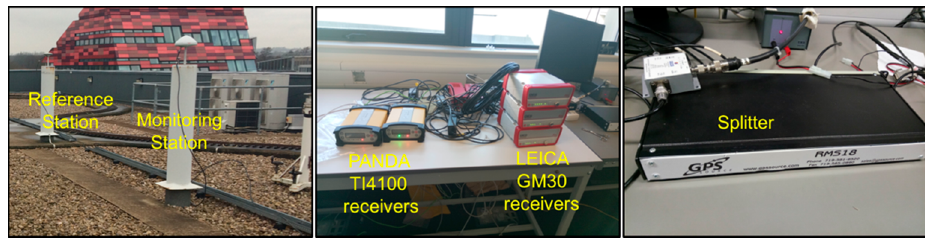
Figure 2. Receiver testing bed of GeoSHM system.